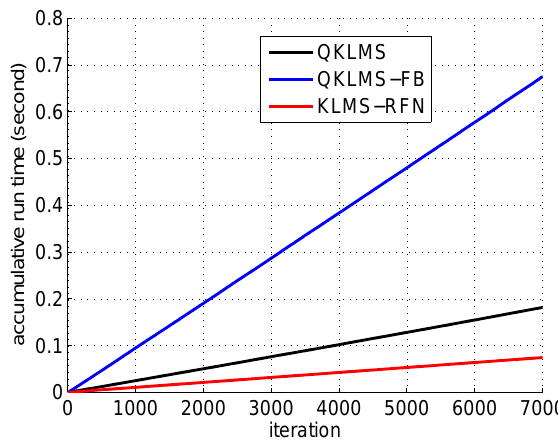
Figure 11. The run time curves of the QKLMS, QKLMS-FB, and KLMS-RFN algorithms in time-varying channel